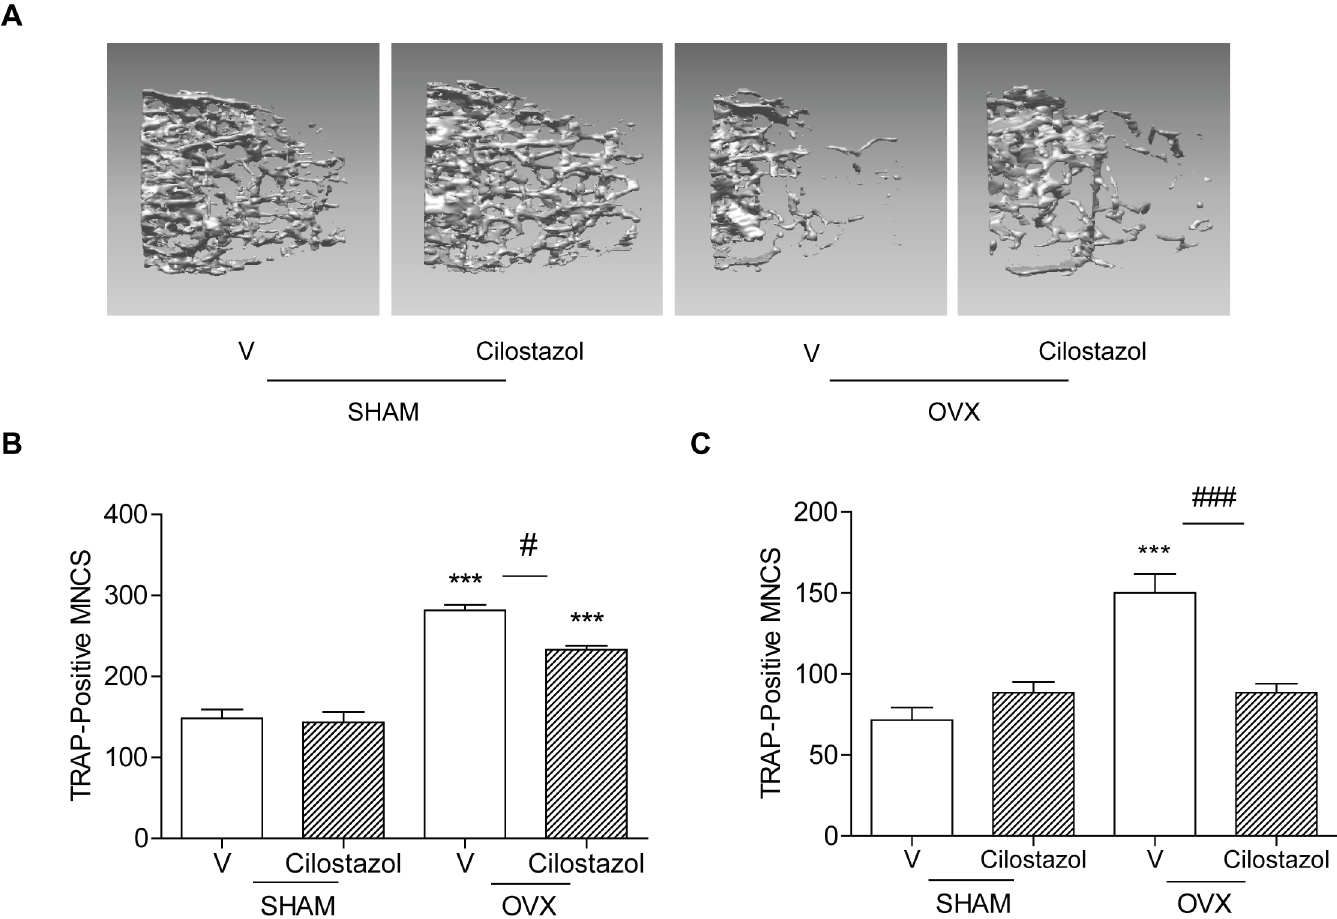
Fig 1. Cilostazol attenuates OVX-induced bone loss in mice. Bone densities of femora were measured on vehicle (V)-treated (SHAM, n = 5; OVX, n = 7), cilostazol (0.5 mg/kg/d)-treated (SHAM, n = 6; OVX, n = 7) mice 8 weeks after surgery. Representative μ CT images of distal femora (1.0 mm from the growth plate of the distal femur) (A). Numbers of OCs in cultures of enriched BMM (5 x 10 3 cells/well) (B) and whole bone marrow (2 x 10 4 cells/well) (C) stimulated with RANKL/M-CSF and 1,25(OH) 2 D 3 , respectively were counted by an experienced observer who was blinded to each treatment for quantification of TRAP-positive MNC/ each well using an eye piece graticule at a magnification of Χ 100. Results were expressed as means ± SEM of 3 – 6 cultures per variable. *** , p < 0.001 compared with vehicle-treated SHAM. # , p < 0.05; ### , p < 0.001 compared with vehicle-treated OVX. Similar results were obtained in three independent experiments.